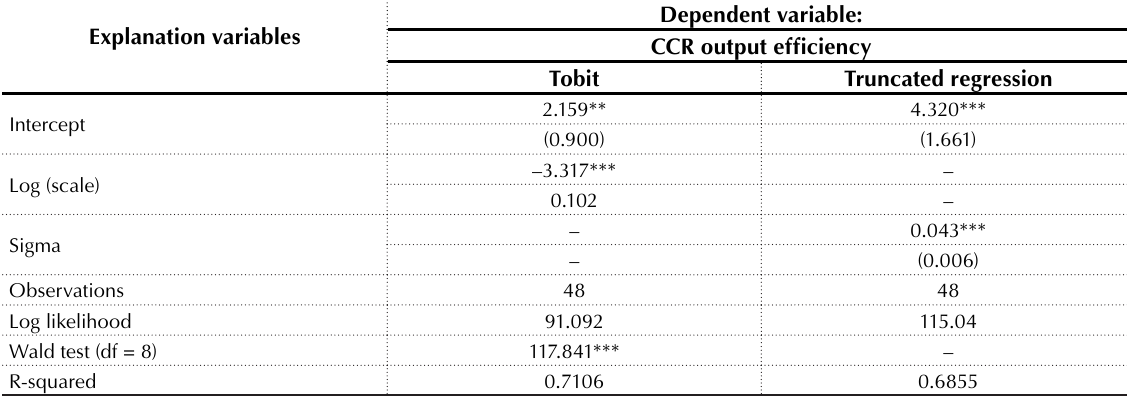
Table 5 (cont.). Regression models